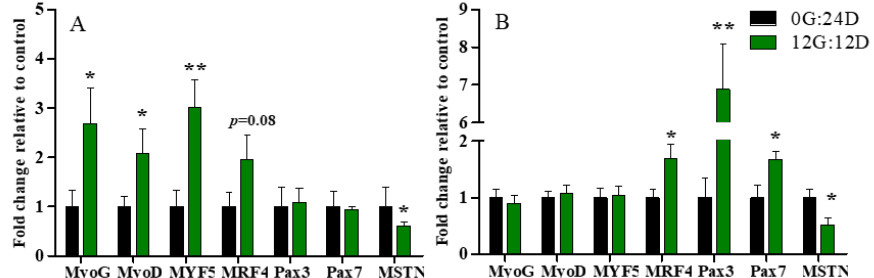
Figure 4. Relative expression of mRNA in leg muscles of goose embryos incubated in the dark or under monochromatic green light. Panels ( A , B ) represent relative abundances of mRNA for Myo G, MyoD , MYF5 , MRF4 , Pax3 , Pax7 and MSTN on E16 and D1, respectively. Data are presented as mean ± SEM (n = 8 embryos per group). * p < 0.05, ** p < 0.01.